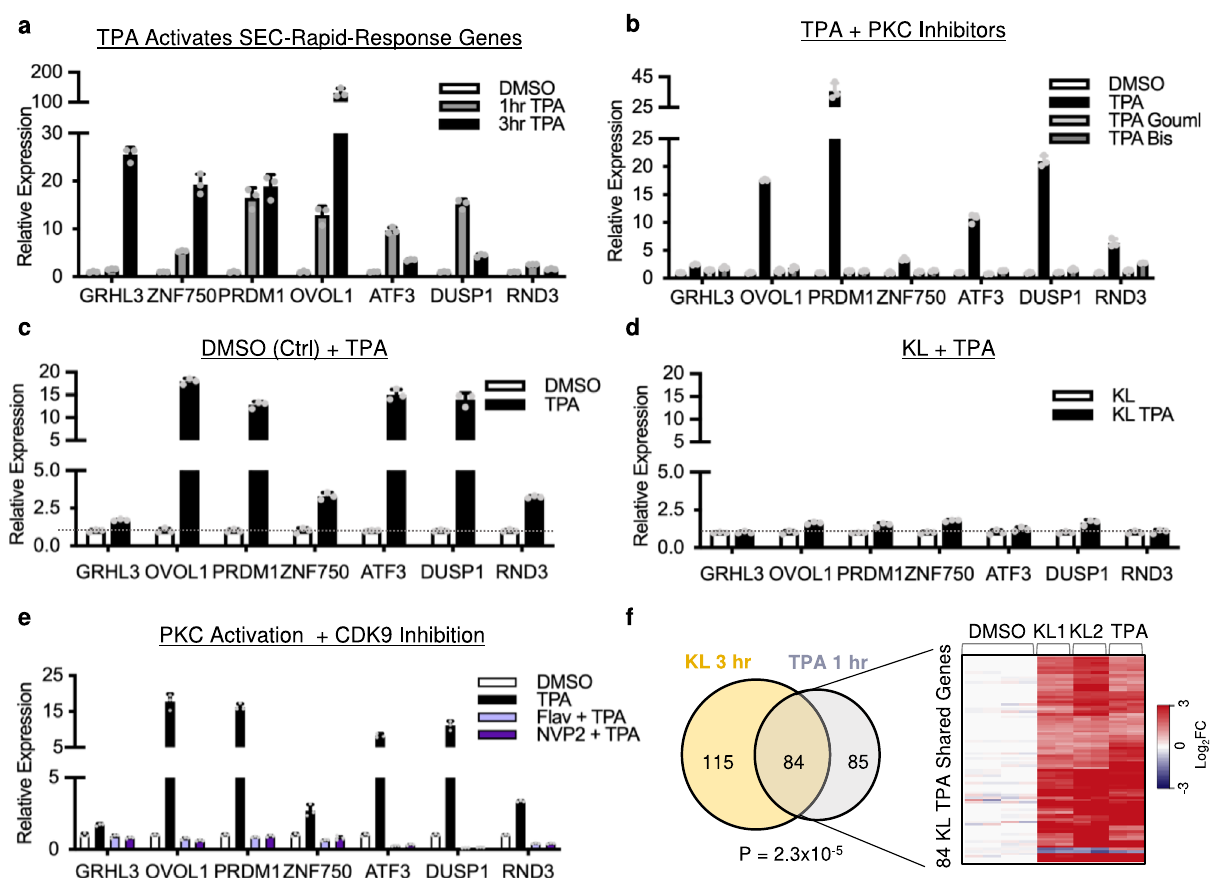
Fig. 7 | SEC mediates the rapid initiation of differentiation in response to PKC signaling. a qRT-PCR comparing the relative mRNA expression of differentiation- activating TFs as well as ATF3, DUSP1, and RND3 with 1hour or 3hours of TPA treatment relative to DMSO control ( n =3 technical replicates, data are presented as mean values±standard deviation). b qRT-PCR shows that the PKC inhibitors, gouml6983 (Gouml) or bisindolylmaleimide I (Bis), consistently suppress the upregulation of representative genes induced by TPA treatment (1hour) as com- paredwiththeDMSOcontrol( n =3technicalreplicates,dataarepresentedasmean values±standard deviation). c , d qRT-PCR comparing gene expression induced by